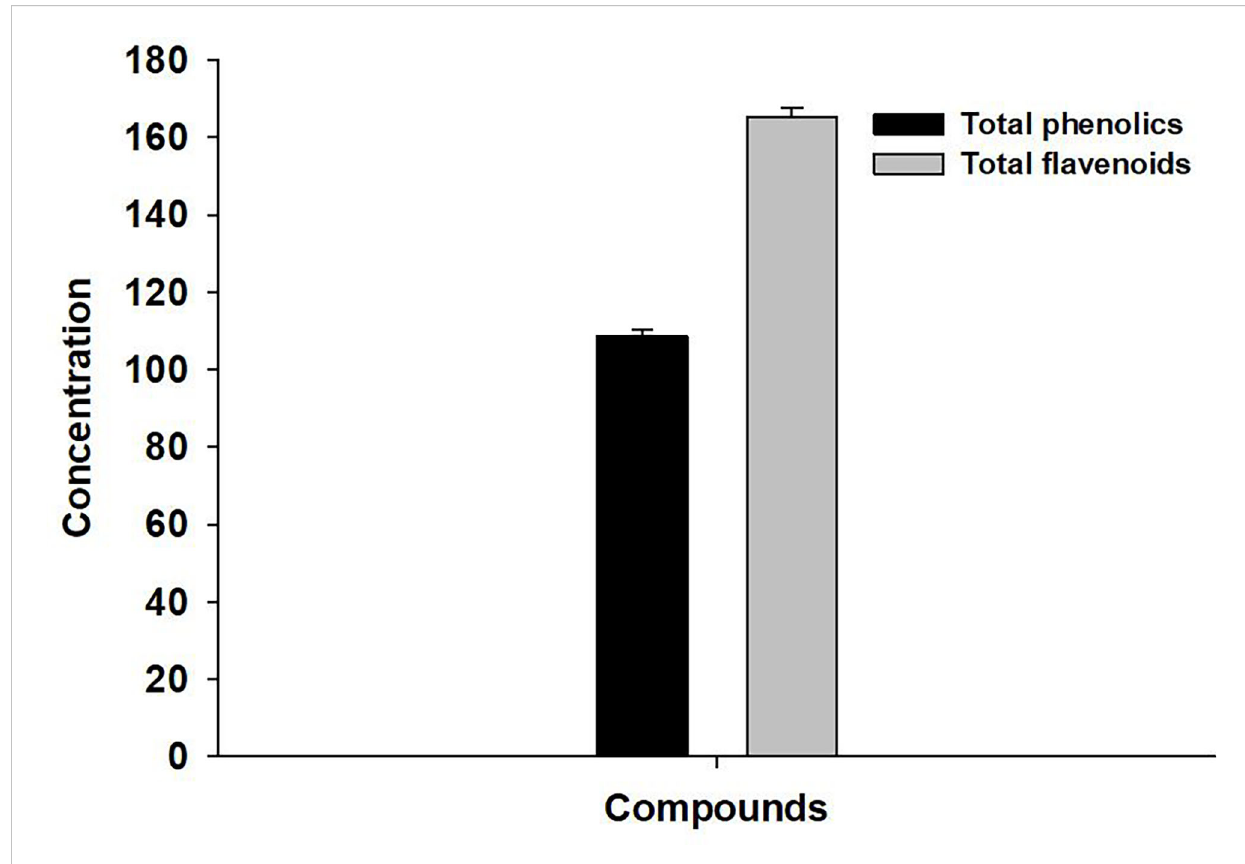
FIGURE 1 Concentration of phenolics (mg) and fl avonoids (mg) in A. indica leaves